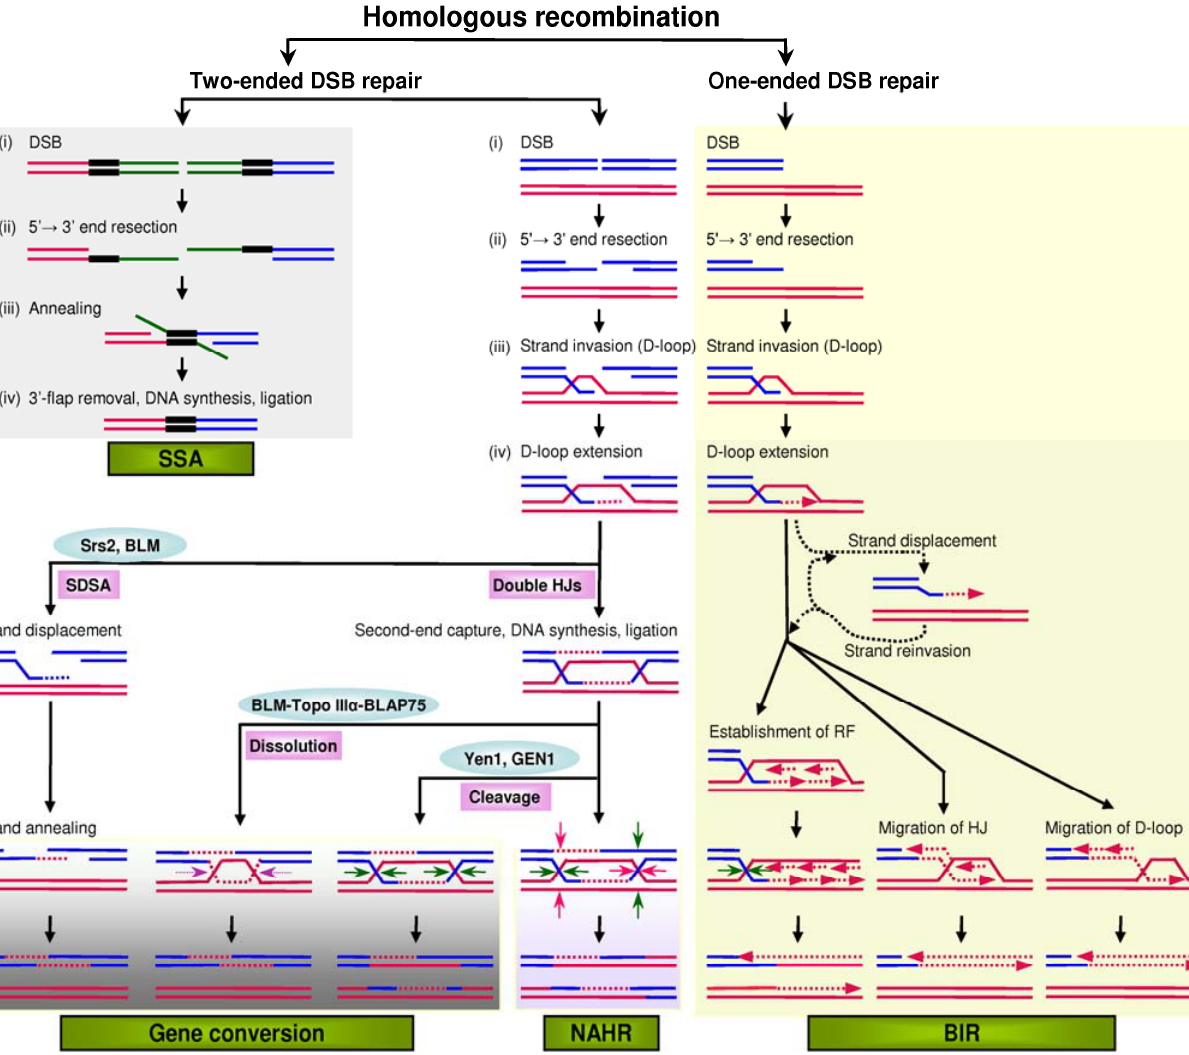
Figure 1. Mutational models of homologous recombination. In the models of gene conversion, NAHR (non-allelic homologous recombination) and BIR (break-induced replication), the invading strand invariably binds to a homologous sequence. In the model of SSA (single-strand annealing), the black bars indicate the direct repeats that flank a DSB (double-strand break). In the dissolution model of gene conversion, the two facing horizontal purple arrows indicate convergent branch migration. In the double HJs (Holliday junctions) cleavage model of gene conversion, the four horizontal green arrows indicate the orientation of resolution. In the double HJ cleavage model of NAHR, the dHJs can be cleaved as indicated by the green arrows or by the red arrows. In the model of BIR, the invading strand may undergo multiple rounds of displacement and annealing (indicated by dotted arrows) before a stable replication structure is established; this probably reflects repeated attempts to find the other end of the DSB. D-loop, displacement loop; RF, replication fork; SDSA, synthesis-dependent strand annealing. Reprinted from